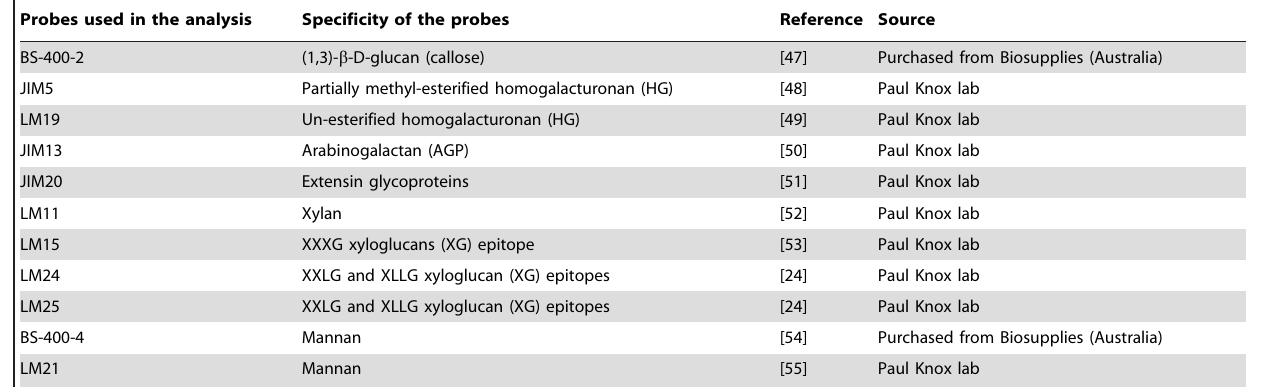
Probes used in the